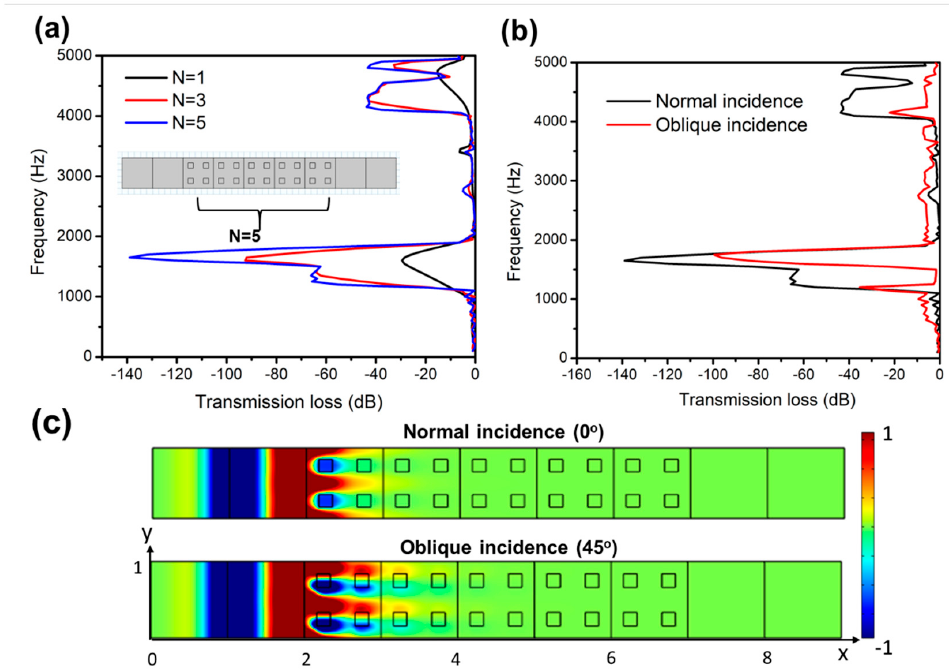
Figure 7. ( a ) Transmission loss spectra of proposed elastic metamaterials with different numbers of unit cells. ( b ) The transmission loss spectra of the five-array elastic metamaterial under the normal and oblique (45 ◦ ) incidences. ( c ) Deformation distributions corresponding to ( b ) at the frequency of 1700 Hz.